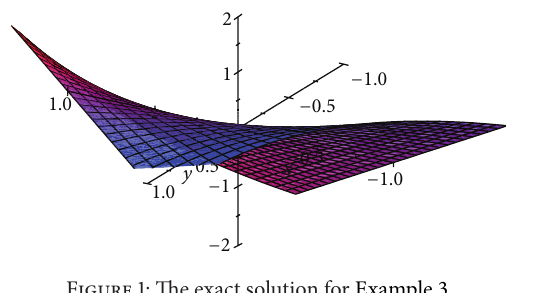
Figure 1: The exact solution for Example 3.